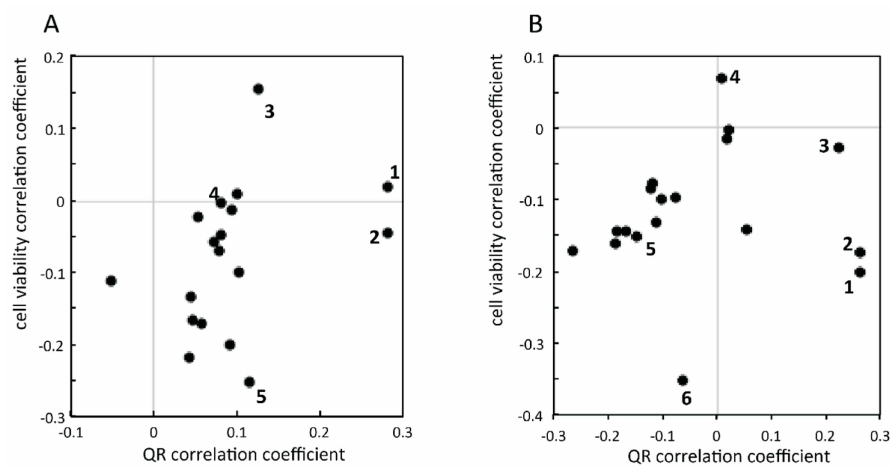
Figure 3. Correlation scatter plots between the two biological evaluations (x axis: QR induction; y axis: cell viability) with compound peak area in the different microfractions. The biological assays were evaluated at 0.08% ( A ) and at 0.8% ( B ). Raw values were transformed using log for QR induction and logit function for cell viability, respectively, before correlation calculation. Some compounds are highlighted in the figure: ( 1 ) 18- β -glycyrrhetinic acid; ( 2 ) 4 1 -bromoflavone; ( 3 ) artemisinin; ( 4 ) phenacetin; ( 5 ) taxifoline; ( 6 )